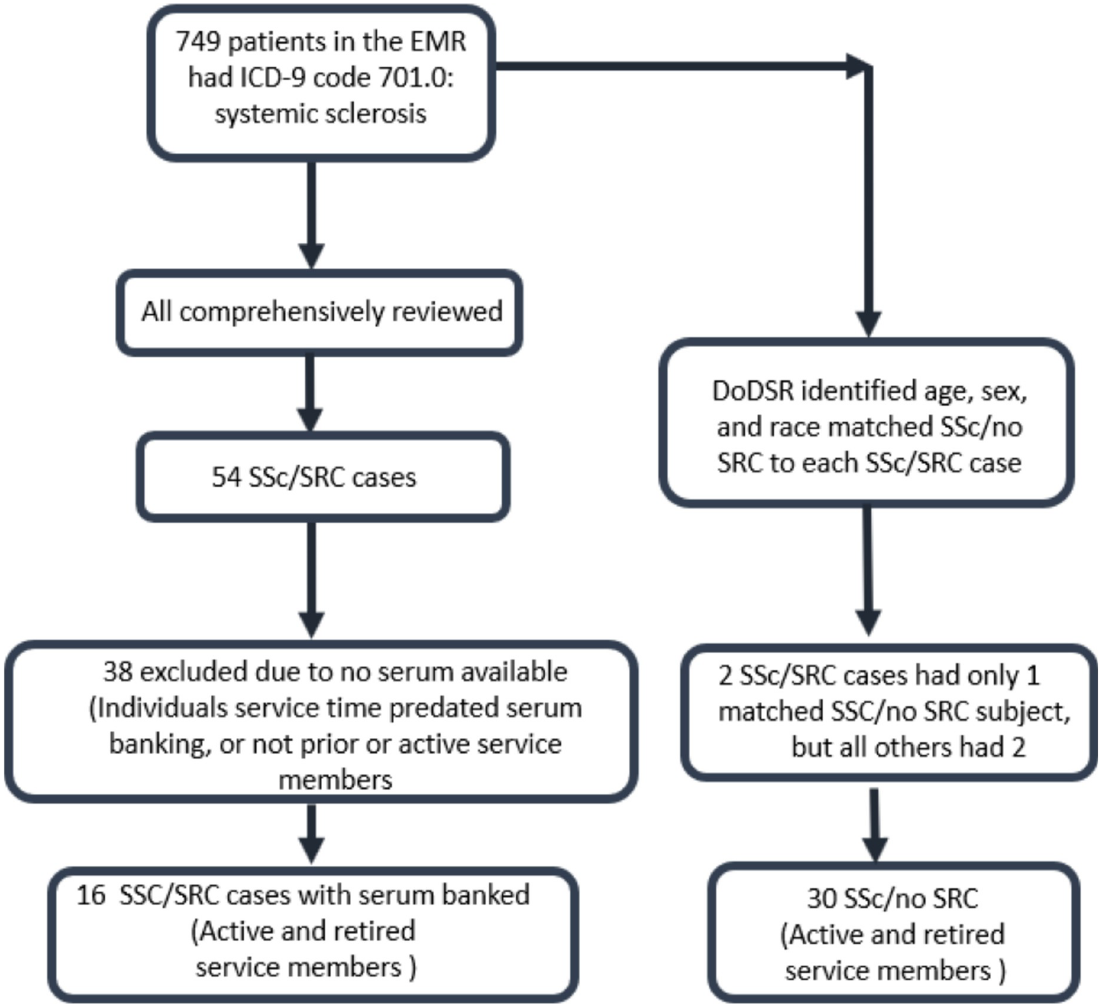
Fig 1. Flow-chart for selection of the SSc/SRC and SSc/no SRC cases. As described in the material and methods, screening of the military electronic medical records between 2005–2016 for Systemic Sclerosis was initially preformed. Following comprehensive review, 54 cases of SS/SRC were identified, of which only 16 had available serum samples. Thirty additional SSc/no SRC cases were then identified that were matched for age, gender and race with the SS/SRC